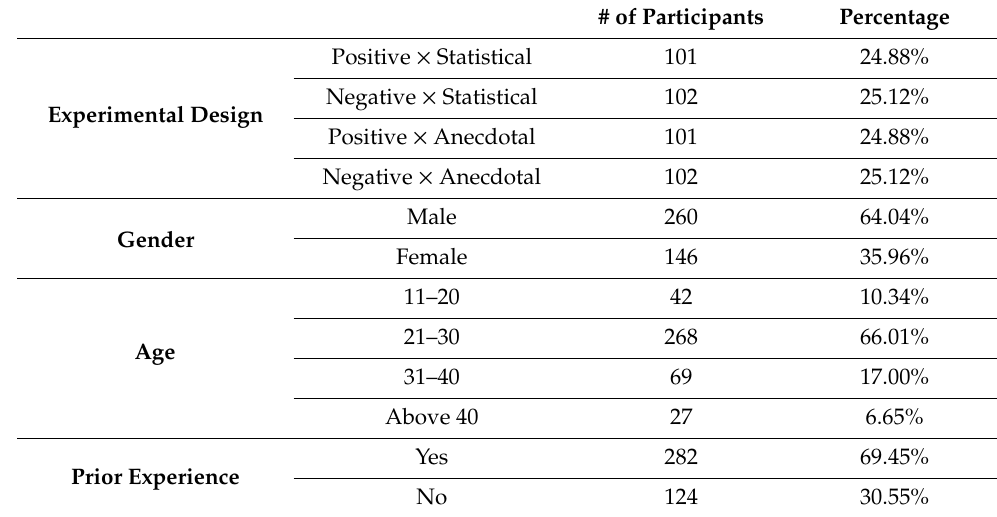
Table 2. Demographic information on the subjects ( n = 406).